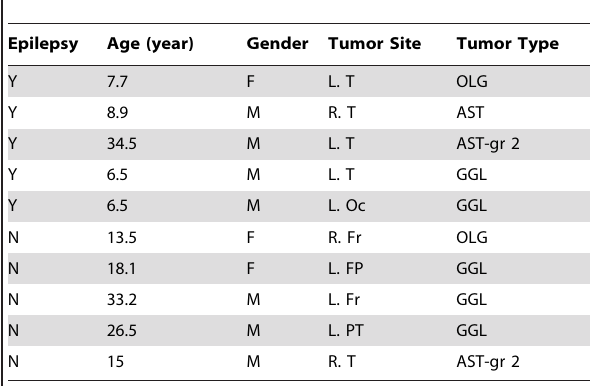
Table 4. Clinical characteristics of study